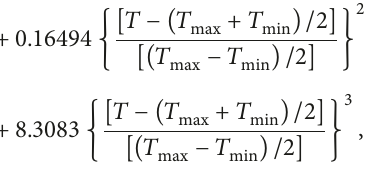
Figure 4: Plot of deviations of experimental data from